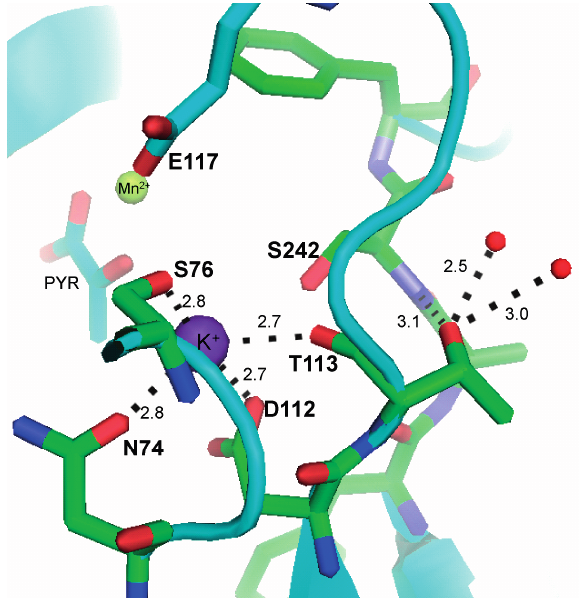
Figure 1. Stick model of the K + binding site of pyruvate kinase from rabbit muscle. The dashed lines from K + (purple sphere) show coordination and distance to the main-chain carbonyl oxygen of T113, O γ of S76, O δ 1 of N74 and O δ 1 of D112. The hydrogen bonds formed between the side chain hydroxyl of T113 and NH of C α of S242 and two water molecules (red spheres) are illustrated. Pyruvate (cyan), Mn 2+ (lime green) and E117 are also illustrated. This figure was constructed from the coordinates of